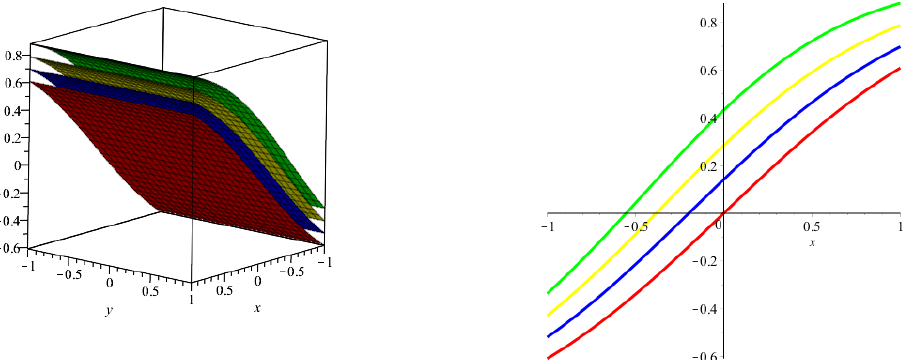
Figure 7. Behavior of the analytical solution at different values of β for problem 2.